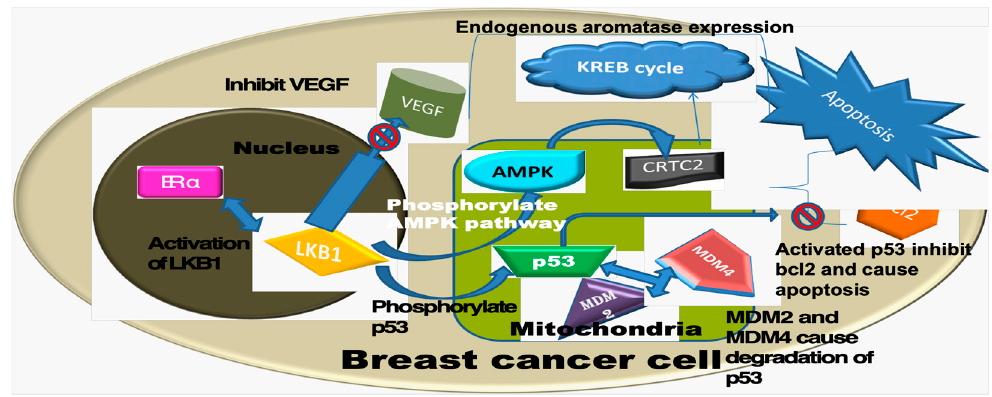
Figure 1. Proposed intracellular mechanism of action of LKB1 as suggested in the cell line studies